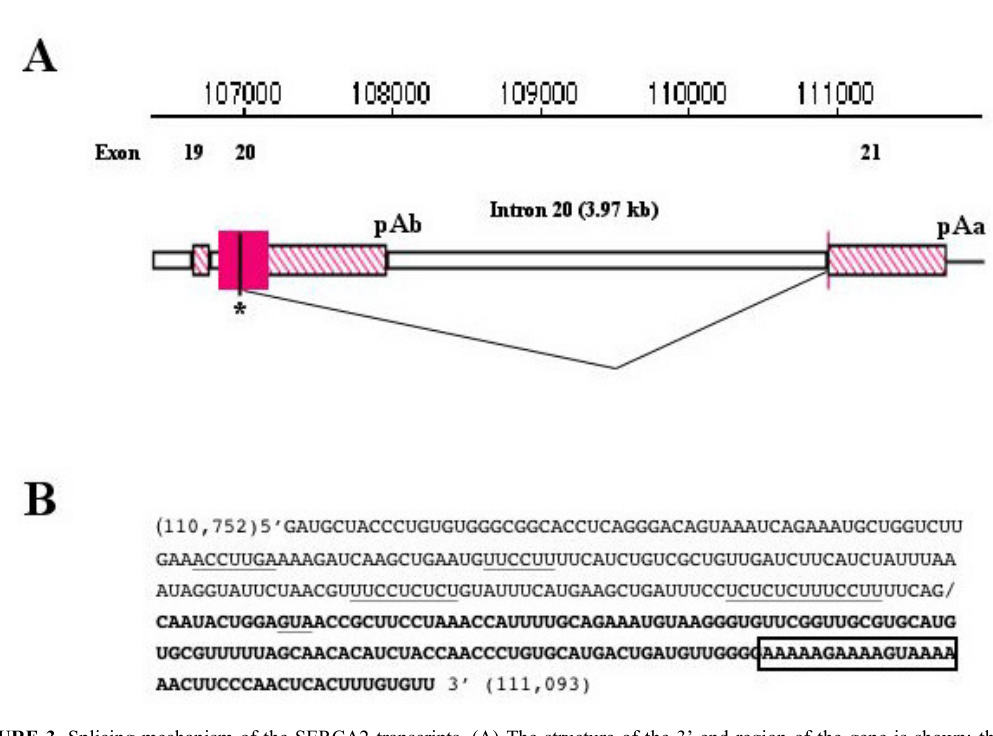
FIGURE 3. Splicing mechanism of the SERCA2 transcripts. (A) The structure of the 3’-end region of the gene is shown; the line indicates the splicing mechanism of the primary transcript to produce the alternate isoforms. The asterisk (*) indicates the position of internal donor site of splicing located in exon 20. pAa and pAb indicate the polyadenylation sites for the SERCA2a and SERCA2b mRNAs, respectively. (B) The nucleotide sequence of the junction region of intron 20 and exon 21 of the human SERCA2 pre-mRNA is shown. The consensus intronic splicing suppressor (ISS) sequences within intron 20 and the stop codon in exon 21 are underlined. The intron/exon junction acceptor site is indicated by a slash (/). The exon 21 sequences are in bold letters. The exonic splicing enhancer (ESE) consensus sequence is